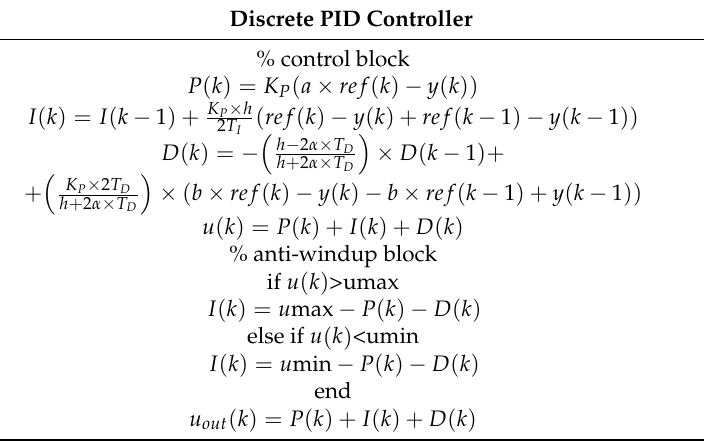
Table 4. Discrete PID